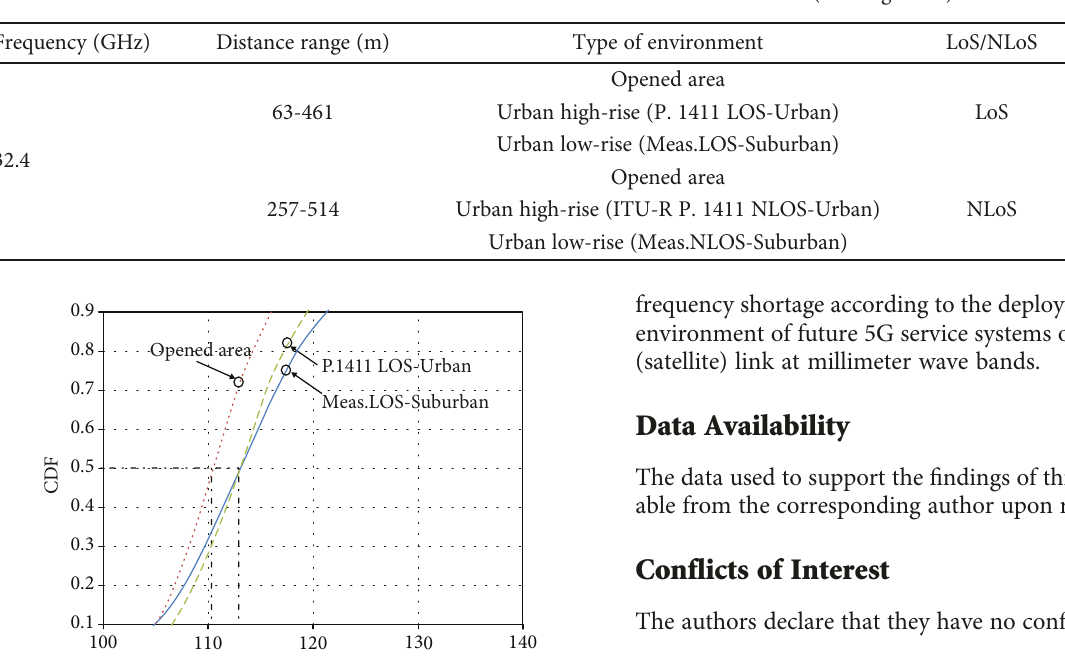
Table 5: Pathloss coe ffi cient in LoS and NLoS environment (at site-general).